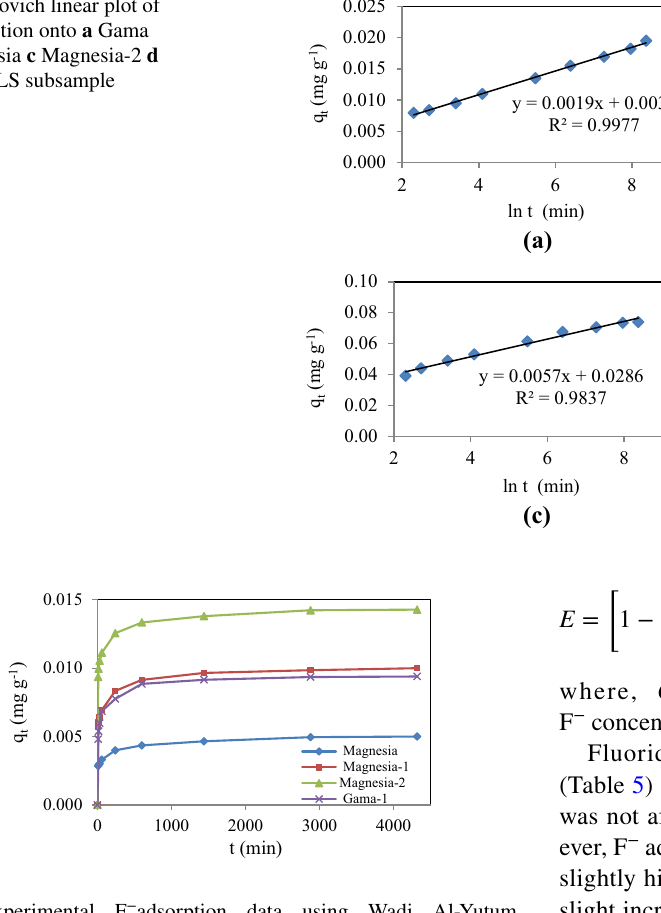
Fig. 8 Experimental F − adsorption data using Wadi Al-Yutum groundwater